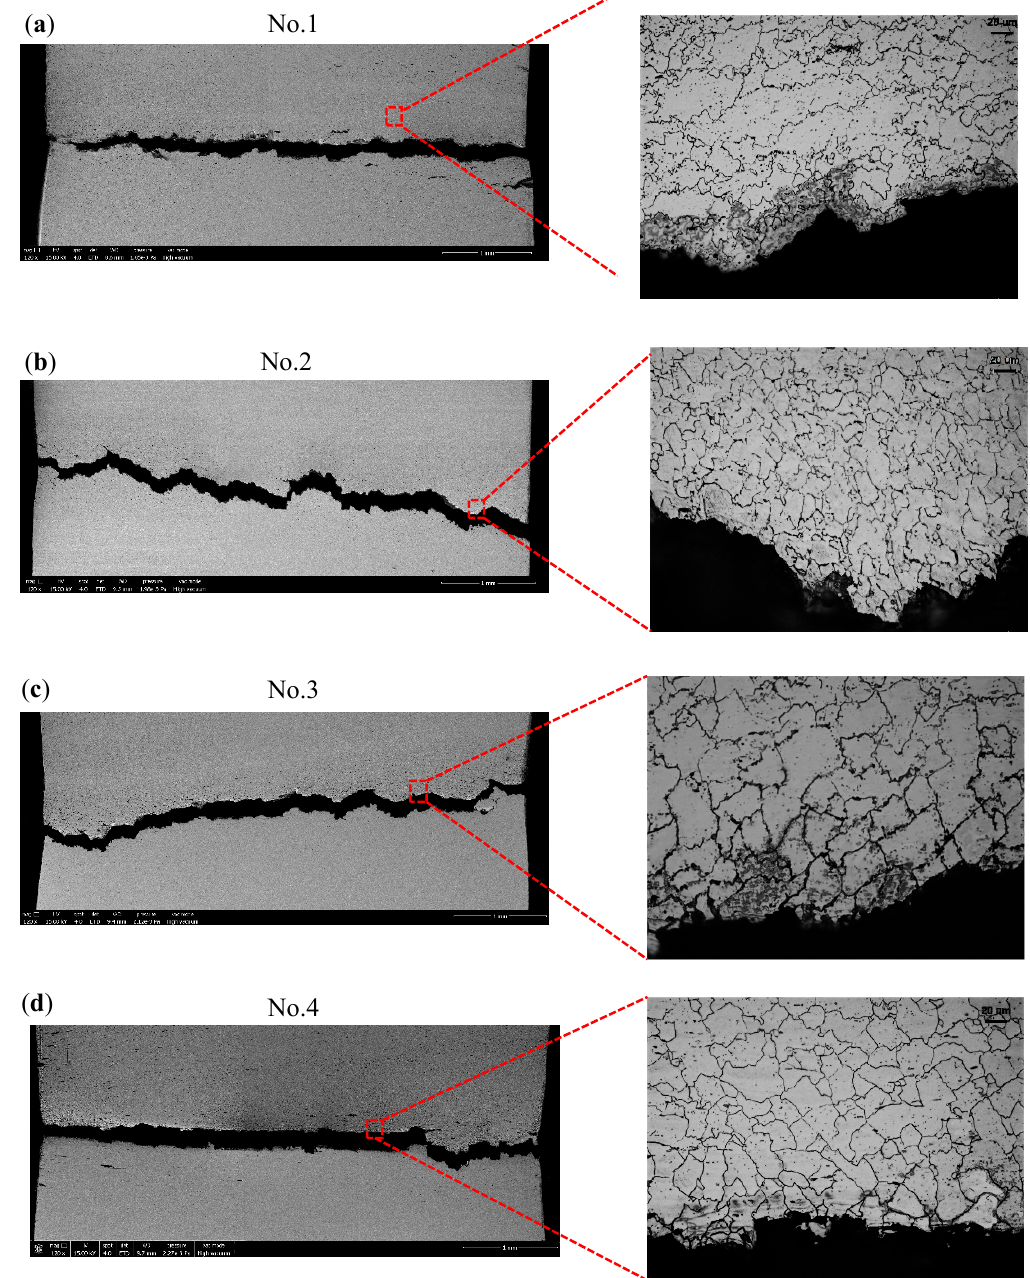
Figure 11. Photograph of macroscopic and microstructure of fracture tensile specimen.